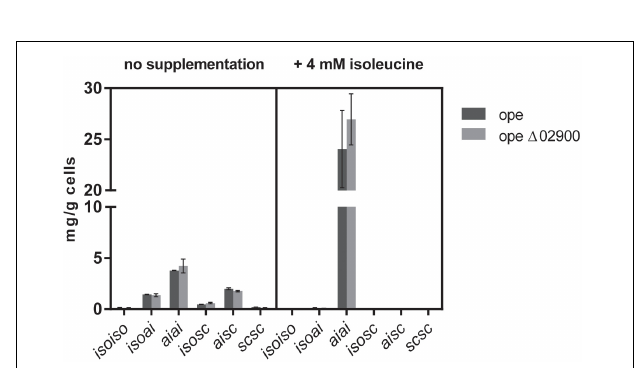
FIGURE 7 | Olefin amounts of dehydrogenase mutant ope (cid:49) 02900:kan in comparison to the parental strain ope grown in minimal medium with and without supplementation of 4 mM isoleucine. Each bar represents the data of two biological replicates, error bars represent standard deviation.